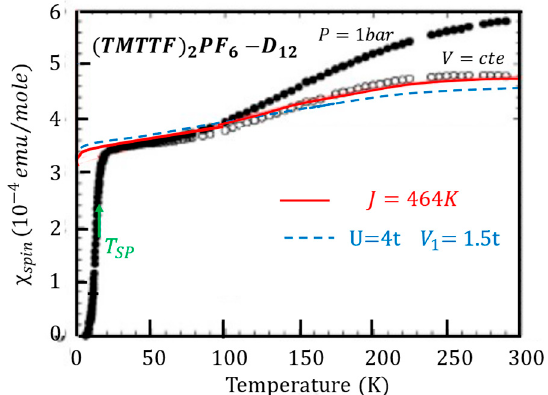
Figure 3. Temperature dependence of the spin susceptibility, χ spin , of deuterated TMTTF 2 PF 6 . The filled circles give the ambient pressure SQUID measurements, and the empty circles give the spin susceptibility at constant volume. The continuous red line is the fit of χ spin with the expression of the spin susceptibility of the localized S —1/2 AF Heisenberg chain [17]. The adjustment shown in the figure, which takes into account both the absolute value and the thermal dependence of χ spin , gives J ≈ 464 K [19]. The dotted blue line is the fit of χ spin for the 1D extended Hubbard model, as detailed in note [23].